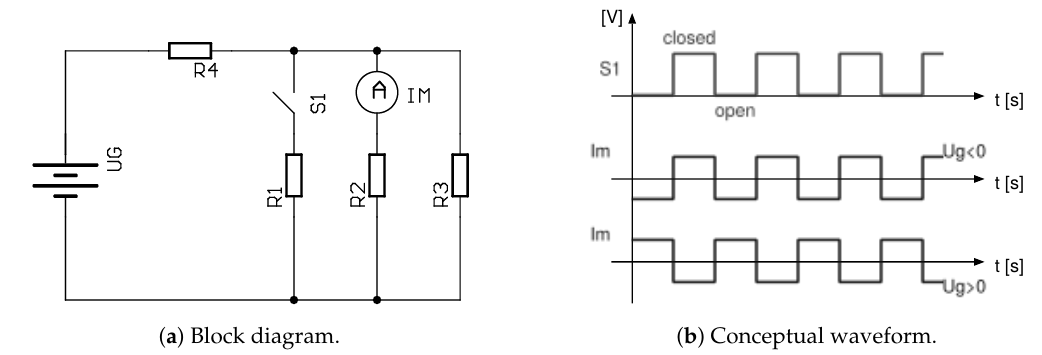
Figure 3. Basic principle of constant (DC) magnetic flux measurement.